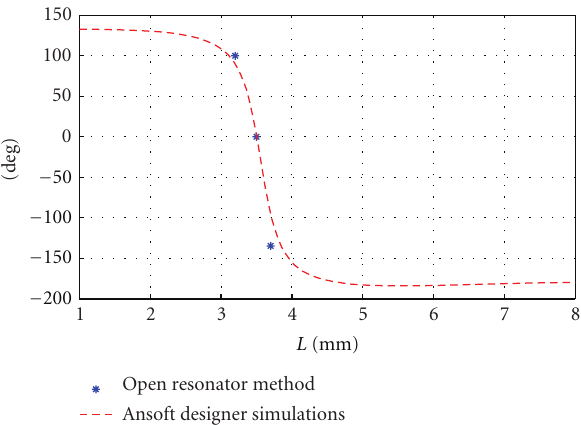
Figure 15: Reflection phase versus patch length L